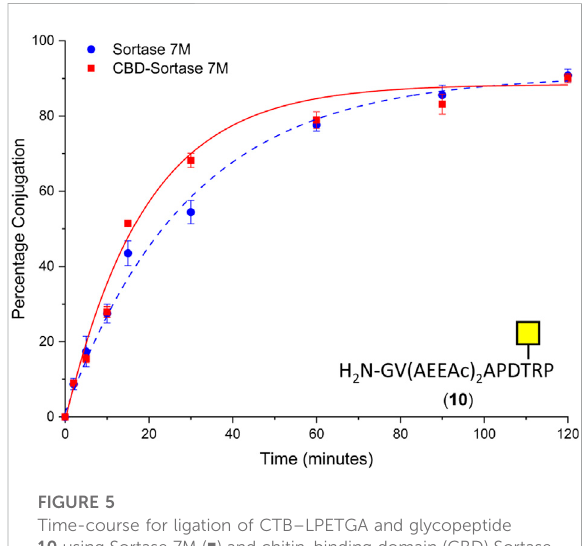
FIGURE 5 Time-course for ligation of CTB – LPETGA and glycopeptide 10 using Sortase 7M ( ■ ) and chitin-binding domain (CBD) Sortase (cid:129) 7M ( ). Percentage conjugation an average of three densitometry measurementsanderrorbarsindicate2×standarddeviation.